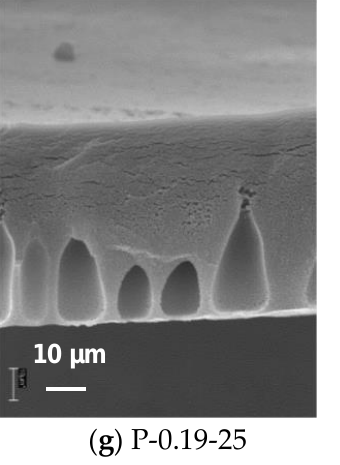
Figure 6. SEM micrographs of the cross-section of ultrafiltration membranes prepared from 15 wt.% PPSU–15 wt.% PEG 20,000–0.5 wt.% PVP K-30-0-0.19 wt.% O-MWCNTs in NMP at coagulation bath temperatures 25 ◦ C ( a – g ), 40 ◦ C ( b – h ), and 70 ◦ C ( c – i ), O-MWCNTs concentrations, wt.%: ( a – c